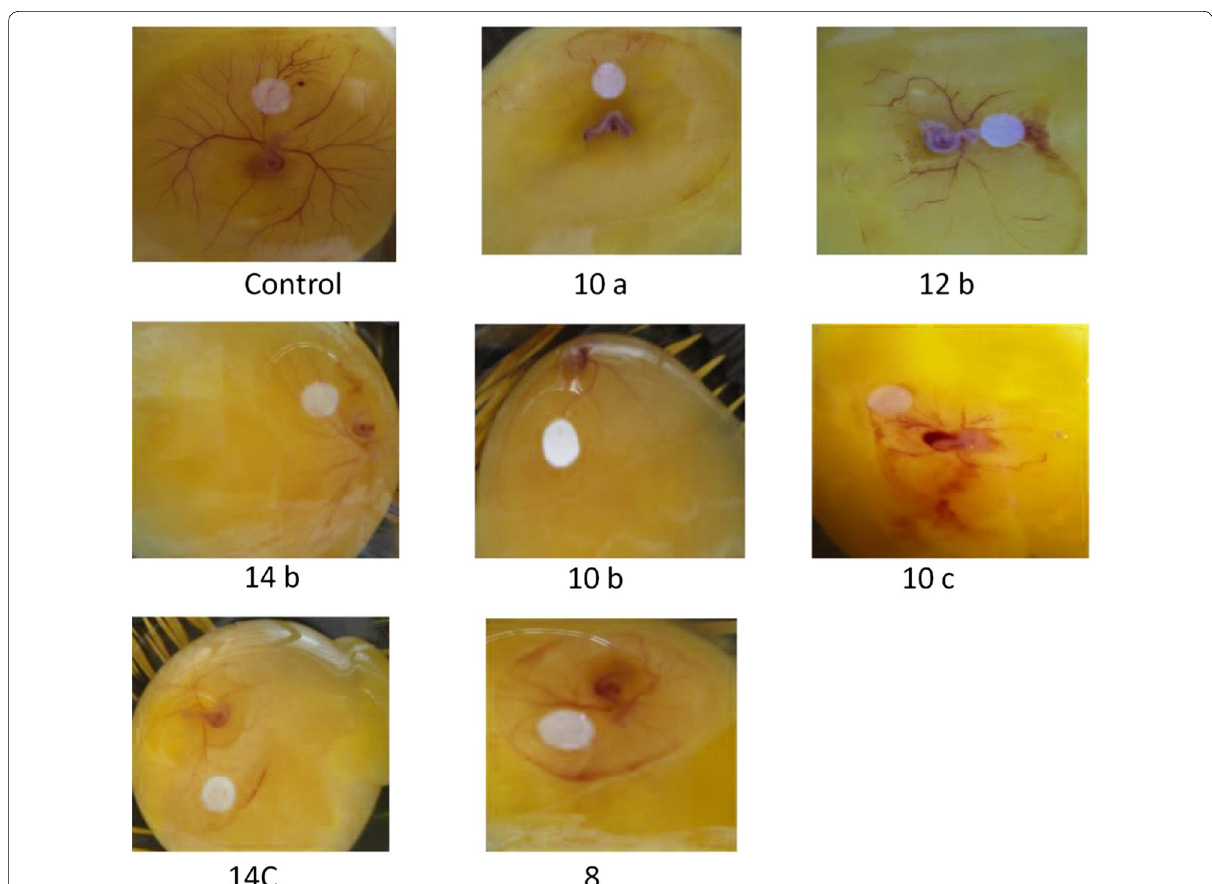
Fig. 1 Suppression of angiogenesis in vivo by novel compounds 10a , 12b , 14b , 10b , 10c and 14c in shell less CAM assay. Decreased vasculature was observed in treated groups compared to control